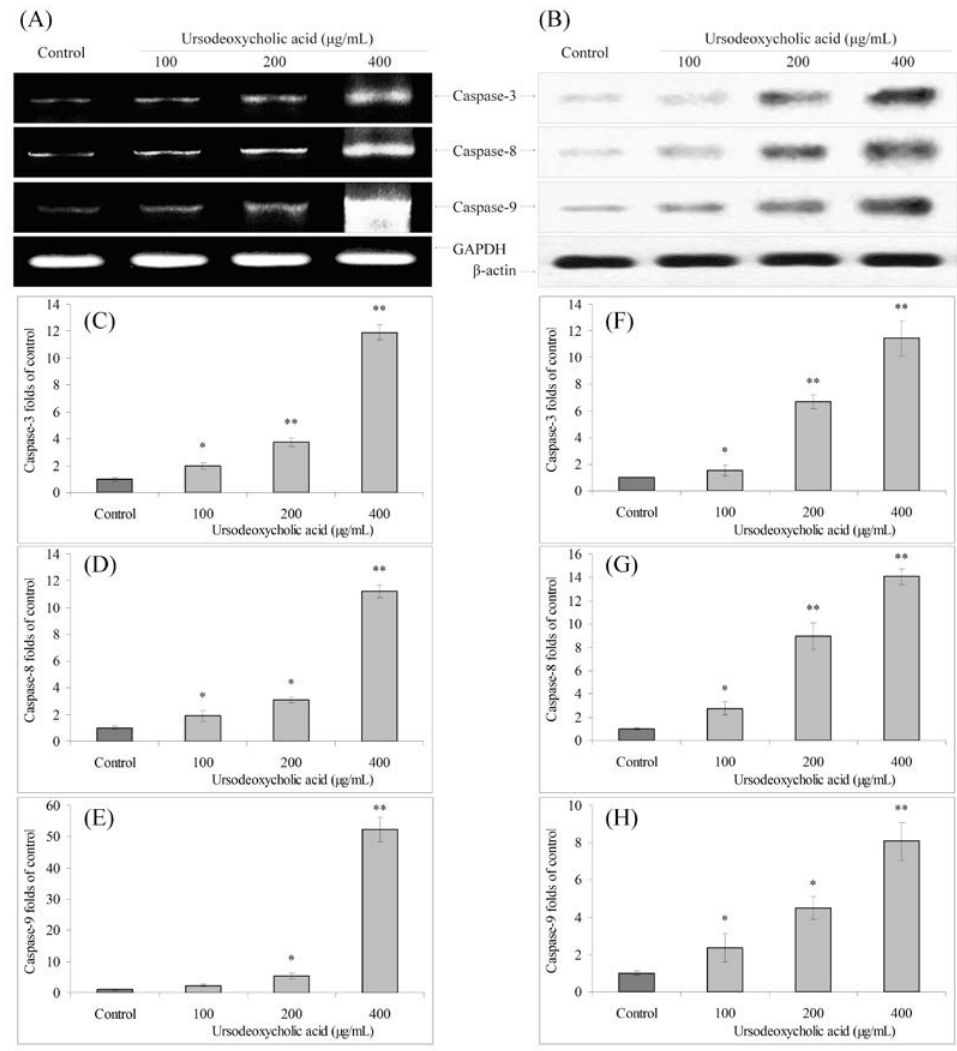
Figure 3. Effects of ursodeoxycholic acid (UDCA) on the mRNA ( A ) and protein ( B ) expression of capase-3, capase-8 and capase-9 in human oral squamous carcinoma HSC-3 cells. Fold-ratio: gene expression/GAPDH (β-actin) × control numerical value (control fold ratio: 1); ( C ), caspase-3 mRNA expression fold over control; ( D ), caspase-8 mRNA expression fold over control; ( E ), caspase-9 mRNA expression fold over control; ( F ), caspase-3 protein expression fold over control; ( G ), caspase-8 protein expression fold over control; and ( H ), caspase-9 protein expression fold over control. * Mean values are significantly different from control ( p < 0.05) and ** mean values are significantly different from control ( p <